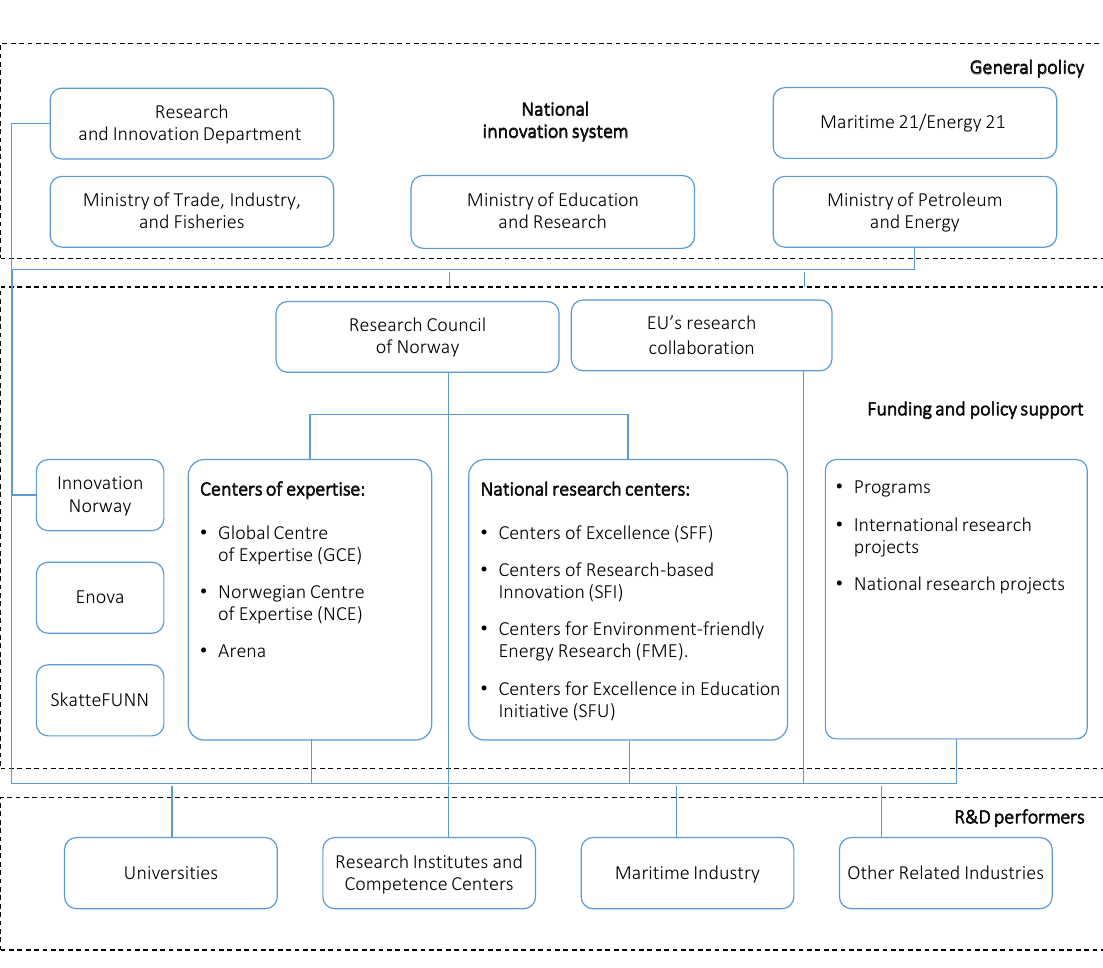
Figure 1. Organizational perspective on innovation in the maritime